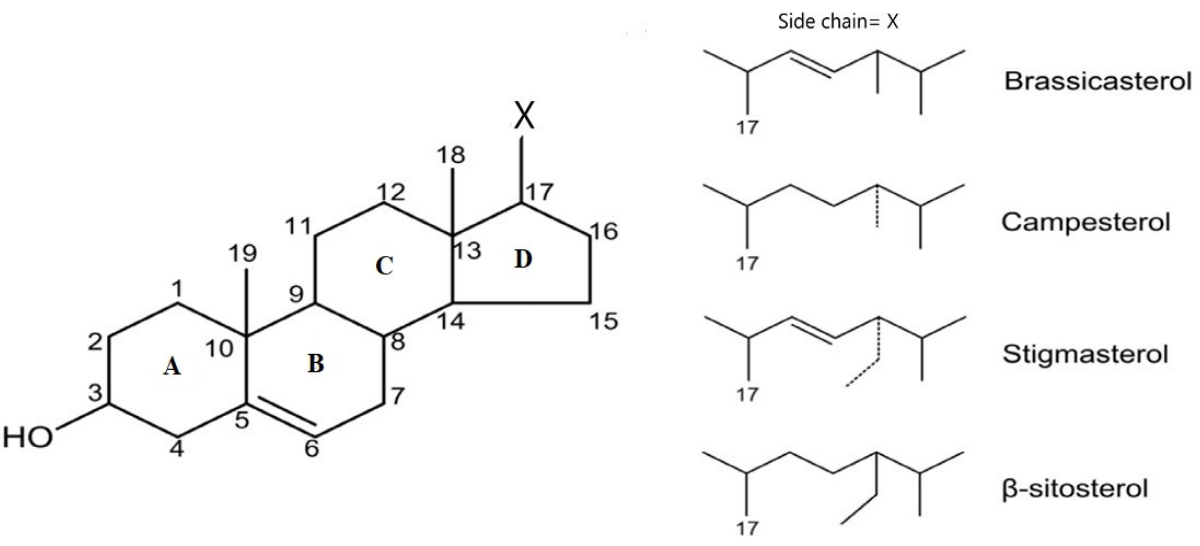
Figure 1. Main PSs chemical structure according to C-17 side